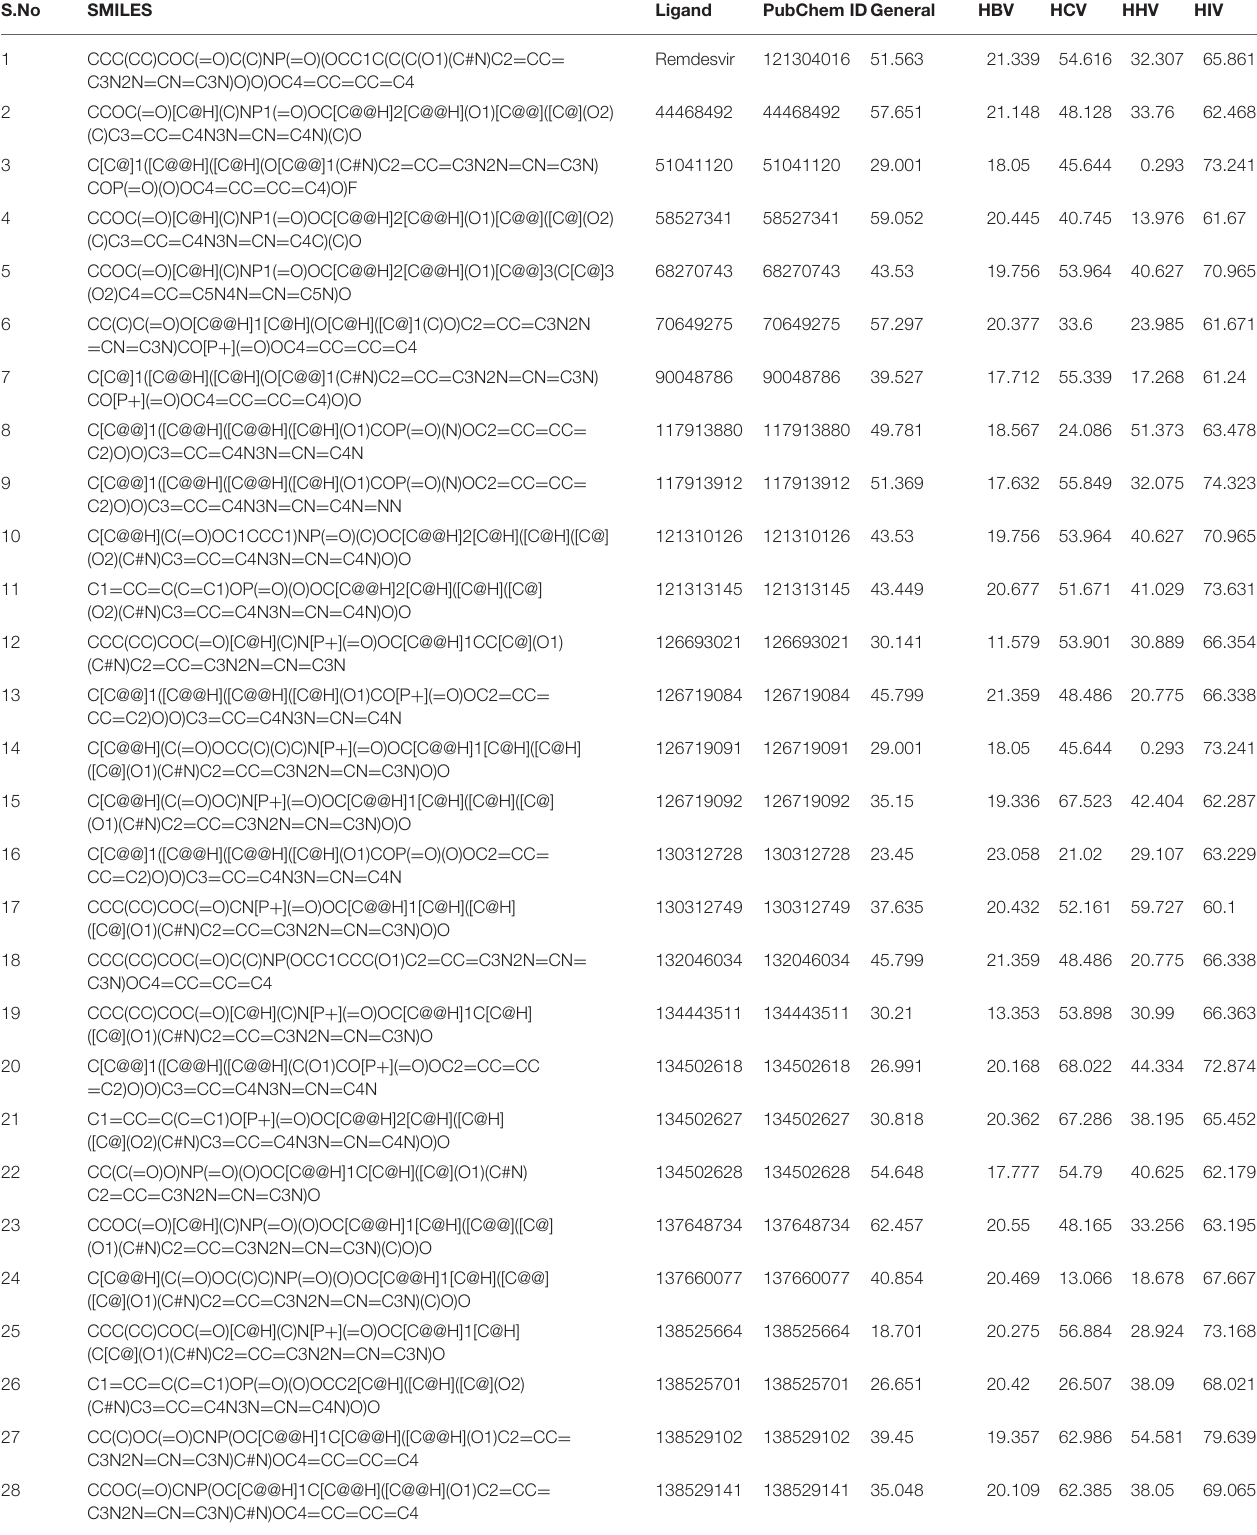
TABLE 1 | Antiviral inhibition percentage prediction of the compounds satisfying Lipinski’s drugability properties. S.No SMILES